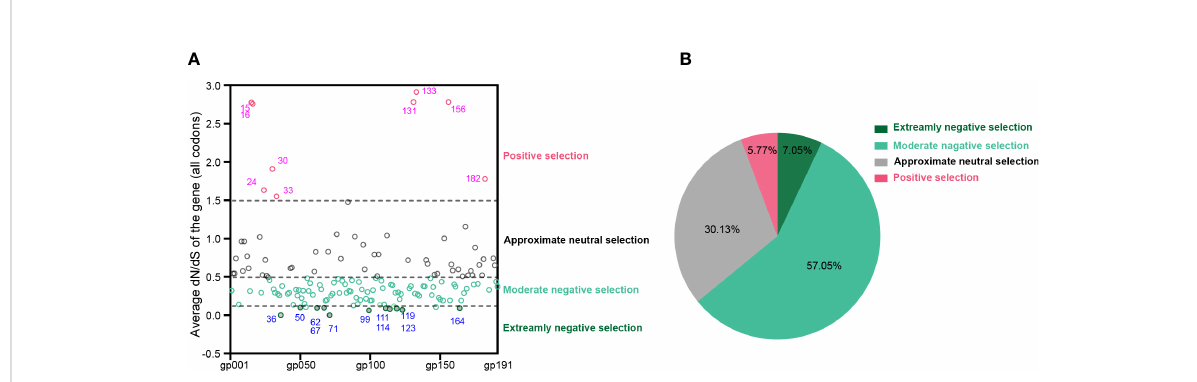
FIGURE 2 Uniform selective pressure at all sites of an MPXV coding gene. (A) The distribution of MPXV genes under different selection pressures. The genes are shown as their protein product names (e.g., MPXVgp001 and MPXVgp002). The blue font shows MPXV genes that have been subjected to extremely negative selection, while the magenta font shows those that have been subjected to positive selection at the whole gene level. Data are shown as dots with median, 25th, and 75th percentile lines. (B) The percentage of MPXV genes that are under different levels of uniform selection pressure.